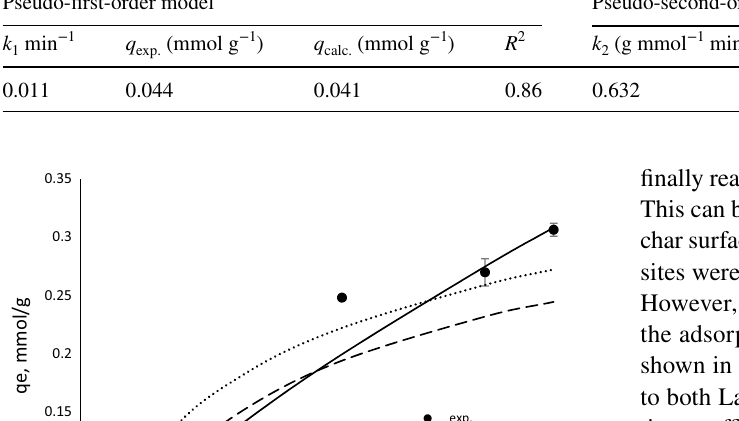
Table 3 Pseudo-first-order and pseudo-second-order kinetic models parameters for Pb 2+ adsorption on DSB550-3 biochar Pseudo-first-order model Pseudo-second-order model